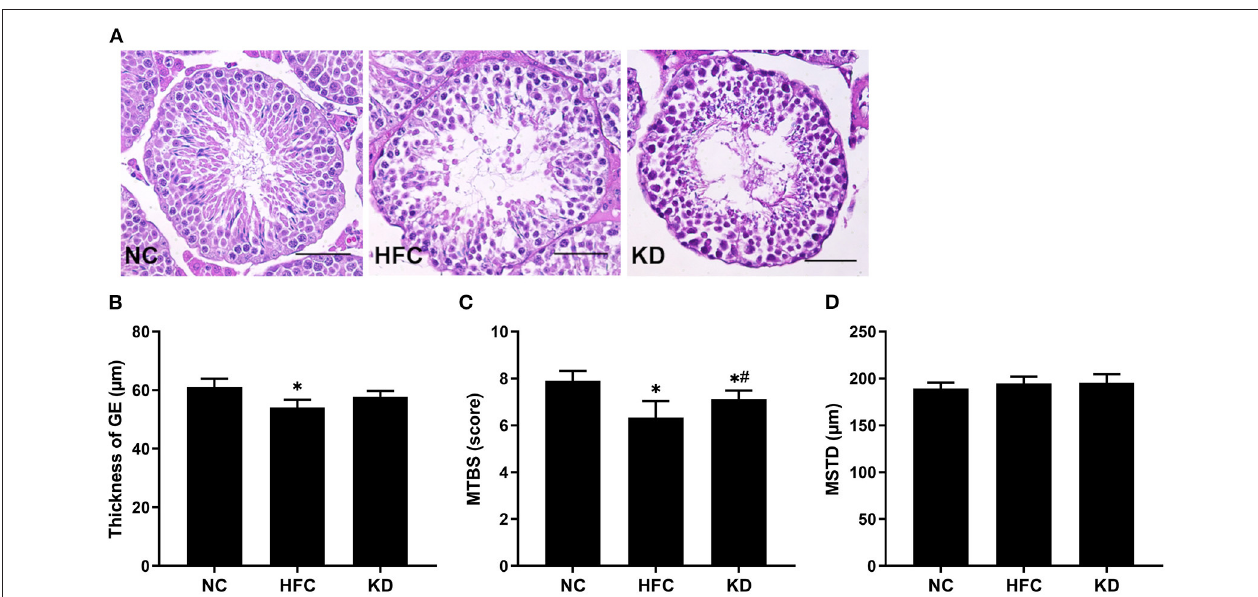
FIGURE 4 | Effects of a high-fat and high-cholesterol diet and a ketogenic diet on (A) testicular histology, (B) thickness of the germinal epithelium (GE), (C) mean testicular biopsy score (MTBS), and (D) mean seminiferous tubule diameter (MSTD) in male mice. Testicular sections were stained with hematoxylin and eosin. * p < 0.05, compared with the NC group; # p < 0.05, compared with the HFC group. NC, normal diet; HFC, high-fat and high-cholesterol diet; KD, HFC diet changed to MCT-based ketogenic diet. Scale bar, 50 µ